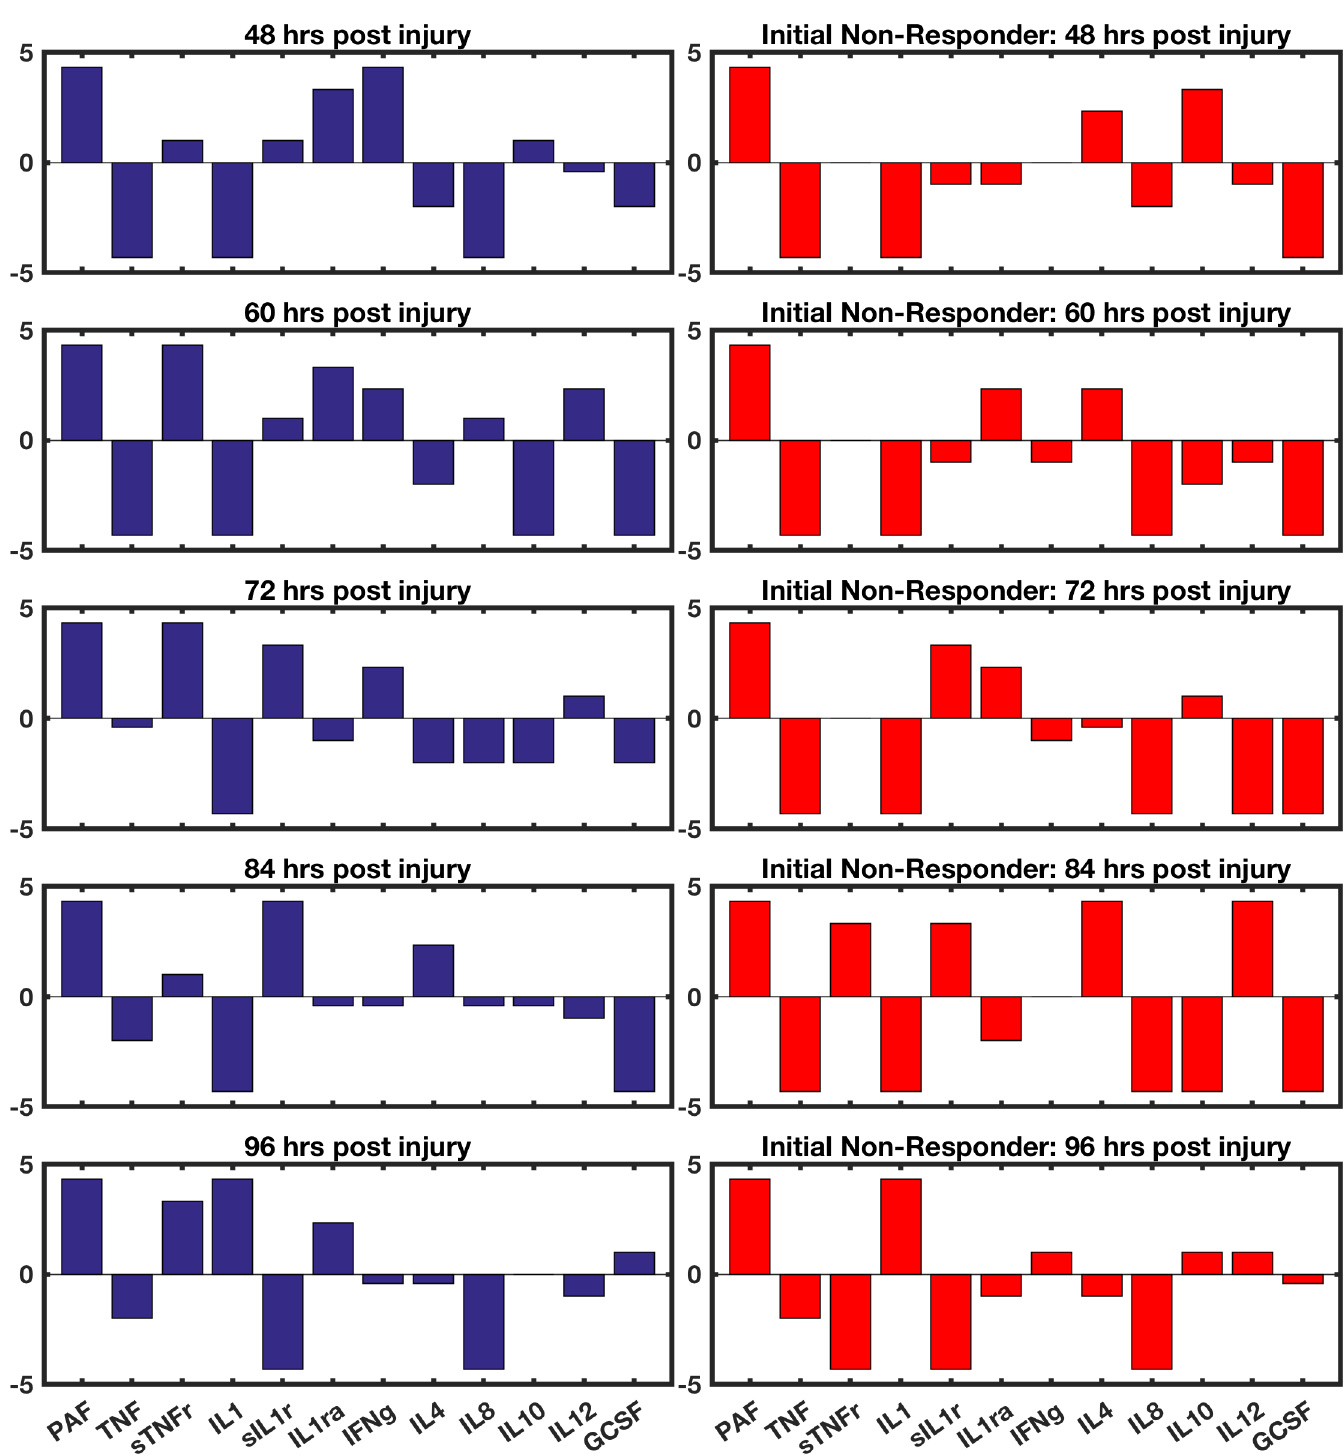
Fig 5. Intervention comparison for responders and non-responder. The set of bar graphs on the left shows the final 5 interventions in a sequence of 8 that showed the greatest success in healing the most in silico patients. The set of bar graphs on the right shows an alternate intervention sequence that was generated by training the genetic algorithm on a patient who was non-responsive to the original intervention. The cytokines operated on are shown on the x-axes and the base-2 logarithm of the augmentation or inhibition strength is shown on the y-axes. The in silico patients received identical interventions for the first three time points. At time point 3, a significant deviation from expected behavior is noted in the non-responder. At this time point, the simulation is halted and used to populate the sample set for a new run of the genetic algorithm. When given the original intervention, this patient has a 75% chance of death at 60 hrs post-injury; the alternate intervention lowers this chance to